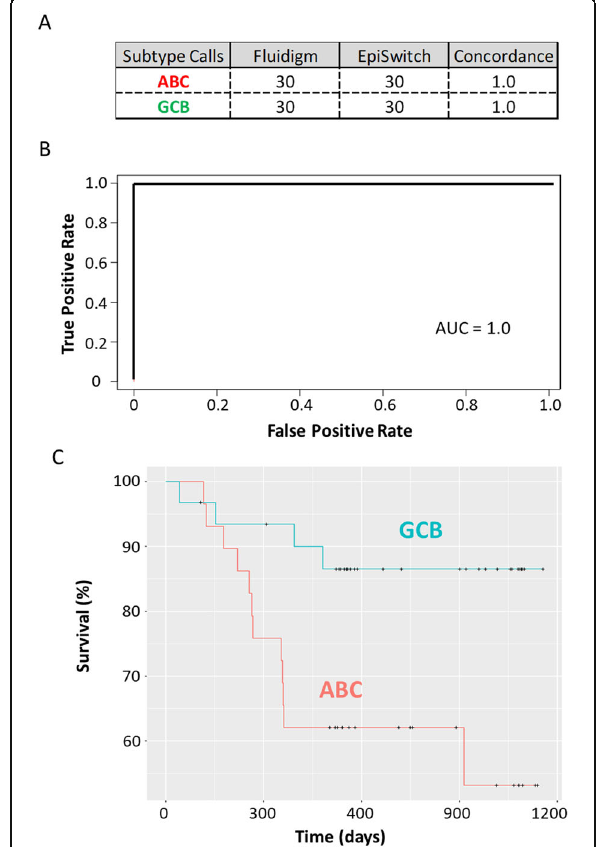
Fig. 3 Overlap of the EpiSwitch DLBCL-CCS and Fluidigm subtype calls and ROC Curve when applied to the Discovery cohort. A. Subtype calls made by the EpiSwitch DLBCL-CCS and the Fluidigm assays on samples of known subtypes. 60 out of 60 samples were identically called by both assays. B. The receiver operating curve (ROC) for the DLBCL-CCS when applied to the Discovery cohort. C. Kaplan-Meier survival analysis (by progression free survival) of samples called as ABC (red line) or GCB (blue line) by the DLBCL- CCS. Samples called as ABC showed a significantly poorer long-term survival than those called as